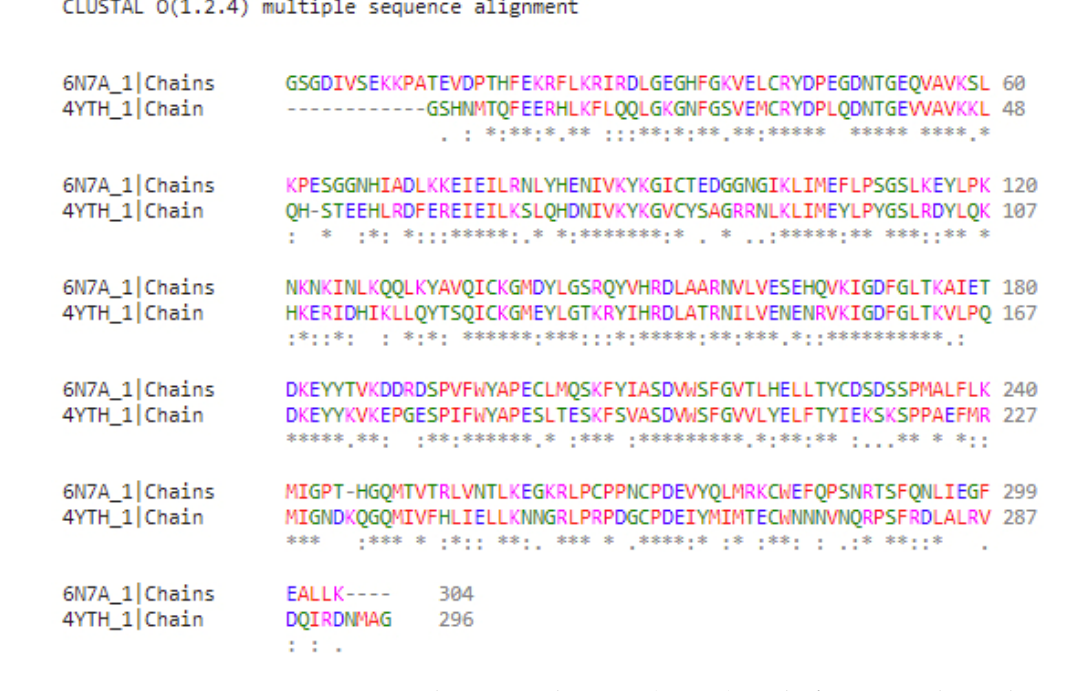
Figure 5. Amino acid sequence alignment (FASTA) results for JAK1 and JAK2 kinases. The symbol (*) under the sequences indicate identity, conservative substitutions (“:”) and semi-conservative substitutions (“.”).